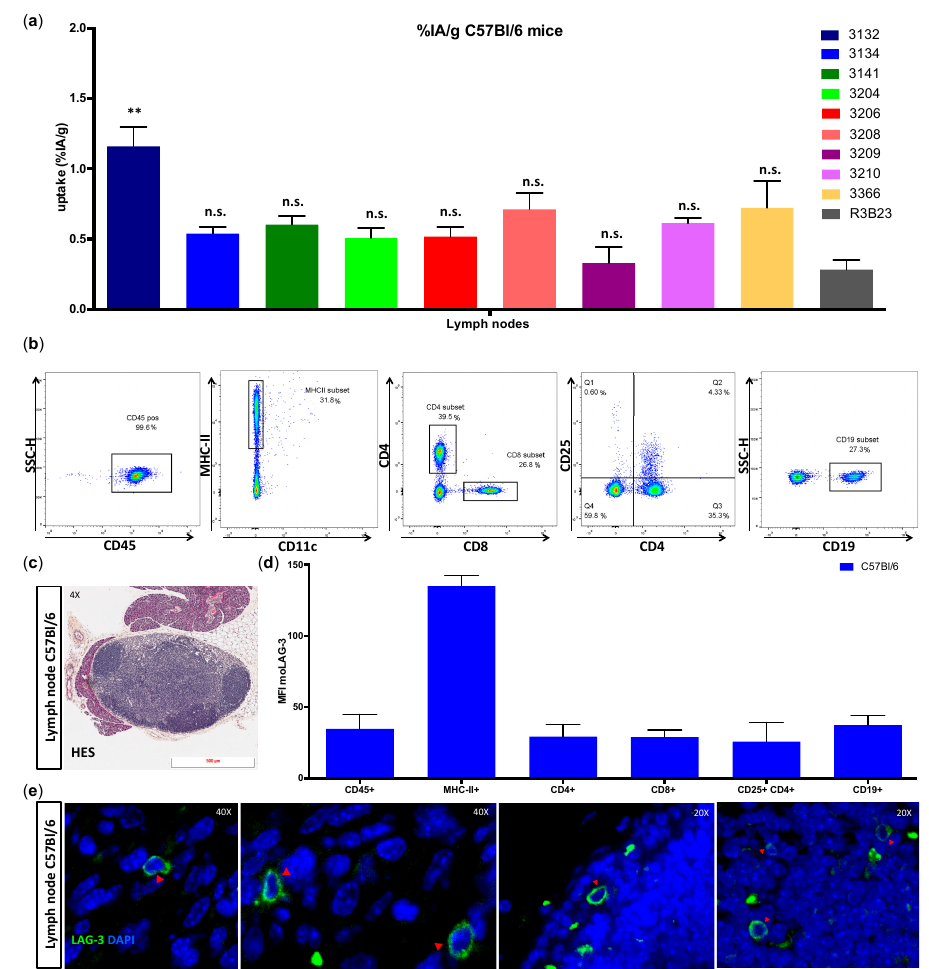
Figure 3. Ex vivo analysis of immune cell populations within submandibular lymph nodes of C57BL/6 mice. ( a ) The graph summarizes the uptake of radiolabeled Nbs in submandibular lymph nodes 80 min after injection of three naive C57BL/6 mice as mean ± SD ( n = 1). ( b ) Flow cytometry gating for single cell suspensions prepared from isolated submandibular lymph nodes. ( c ) Hematoxylin eosin saffron (HES) staining of formalin-fixed, paraffin-embedded (FFPE) submandibular lymph node section. The data shown are representative for three independent mice ( n = 1). ( d ) Expression of moLAG-3 (mean fluorescence intensity, MFI) on different immune cell subsets analyzed by flow cytometry. The graph summarizes the results of three mice as mean ± SD ( n = 1). ( e ) Immunofluorescence microscopy on a lymph node section, stained with moLAG-3 (green) and 4’,6-diamidino-2-phenylindole (DAPI, blue). The red arrows show moLAG-3 expressing cells. The data shown are representative for three independent mice ( n = 1).